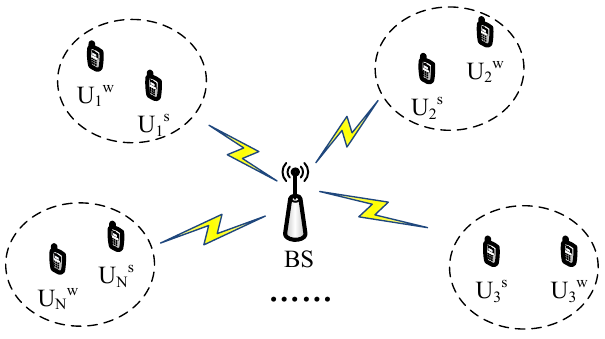
Figure 1. Downlink NOMA system model.